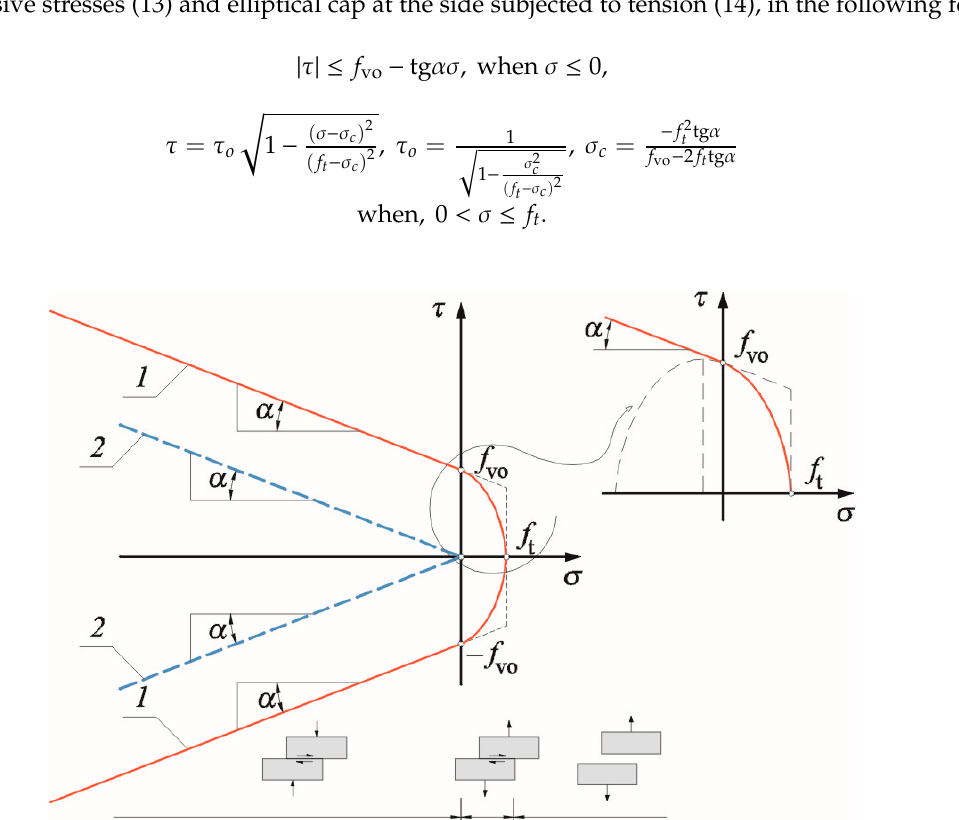
Figure 11. Failure criterion taken for contact elements: 1 —boundary surface, 2— residual surface.